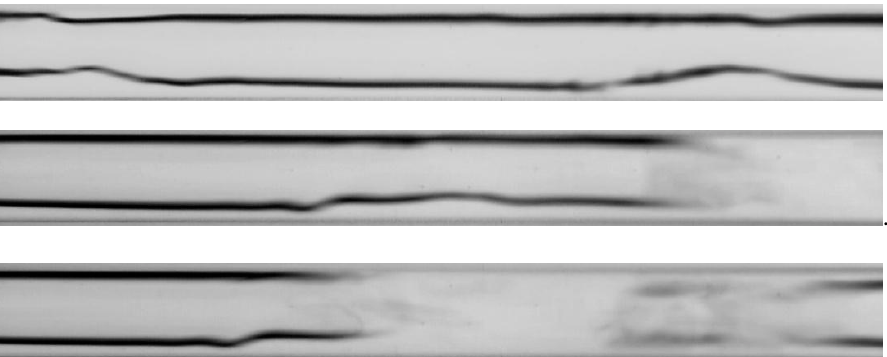
Figure 13. Formation of a slug structure during HFE7000 refrigerant condensation in a minichannel with an internal diameter d h = 0.8 mm ( G = 418 kg/m 2 s; x = 0.008; ϕ = 0.62; t s = 29° C).